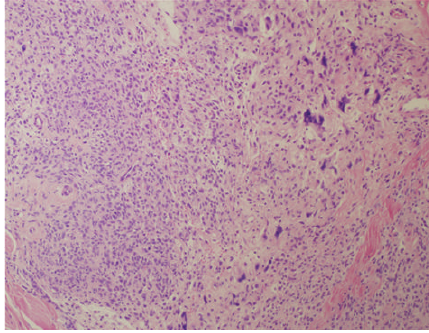
Figure 3: Patternless giant cell and spindle cell proliferation (HE, × 100).